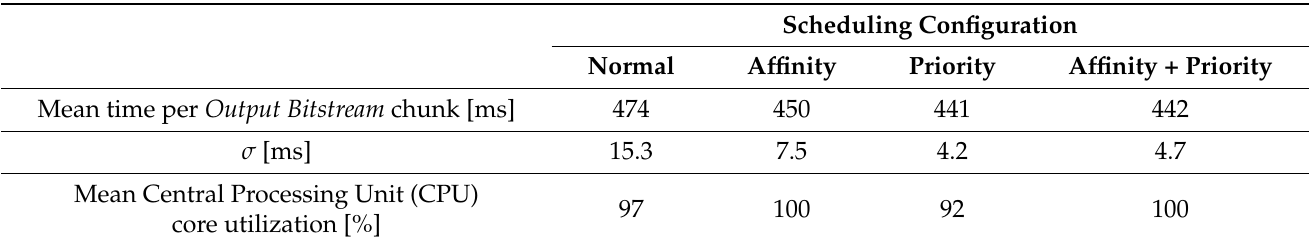
Table 3. Performance metrics of the Stimulation Stream Builder during high-rate pulse insertion stress